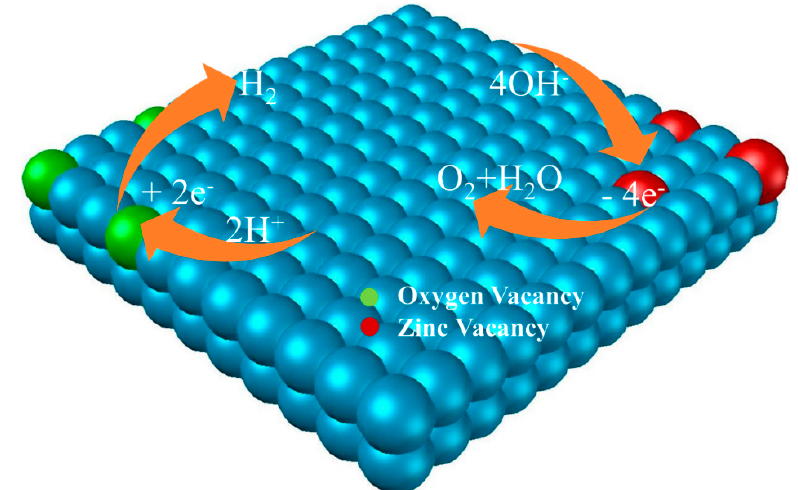
Figure 10. Schematic diagram for working model of OER and HER at different active sites.